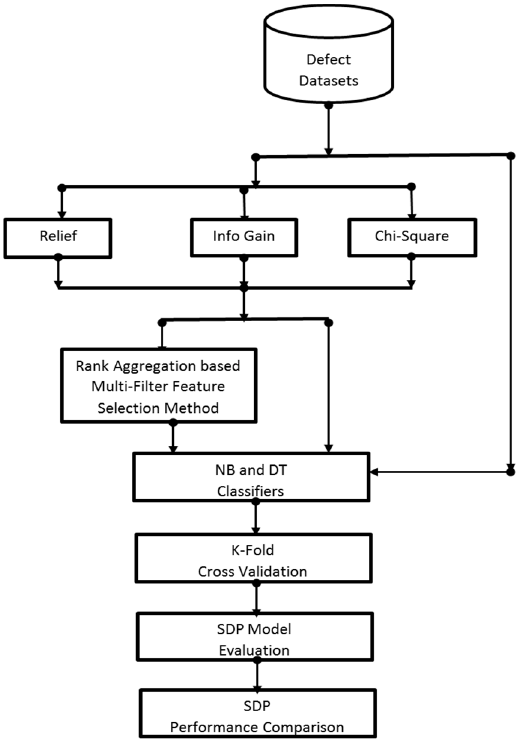
Figure 1. Experimental Framework.